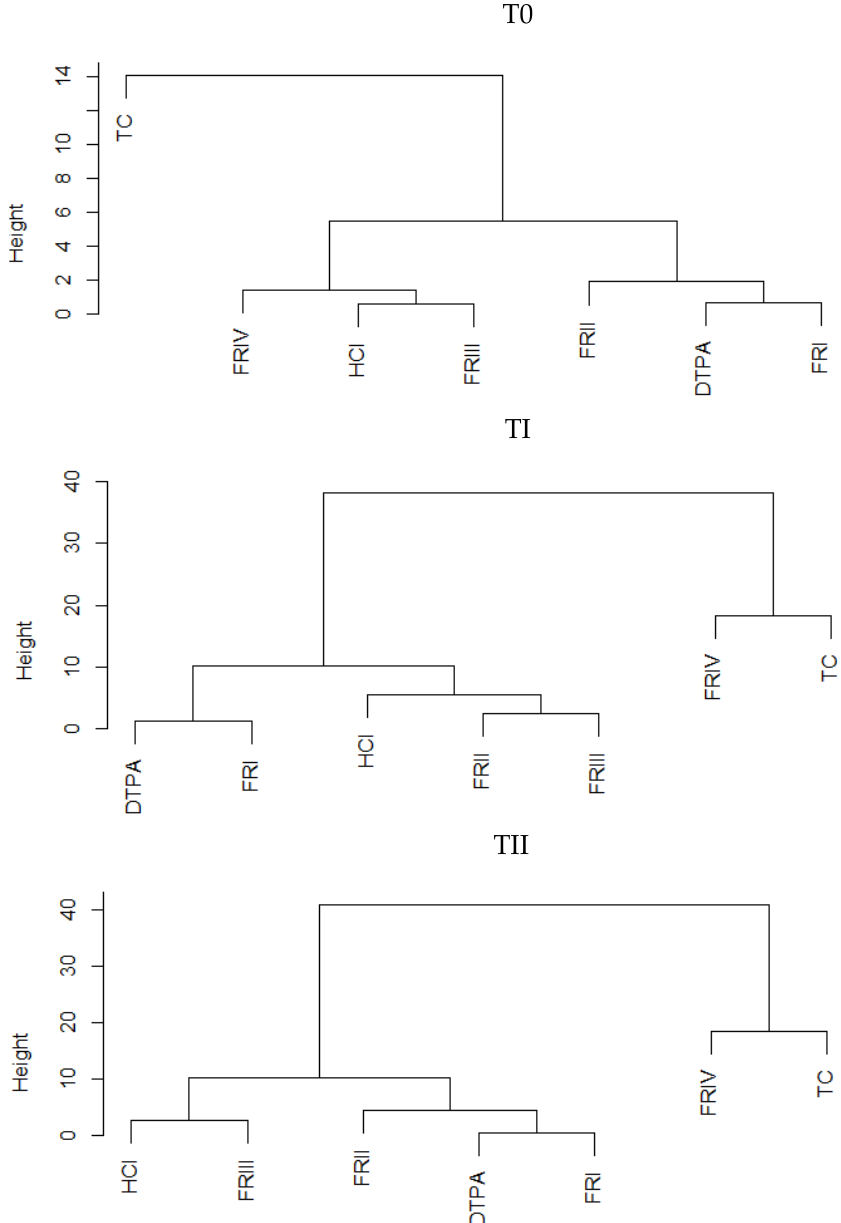
Figure 3. The nickel amounts in soil (T0, TI, TII) in dependence on used extractant .